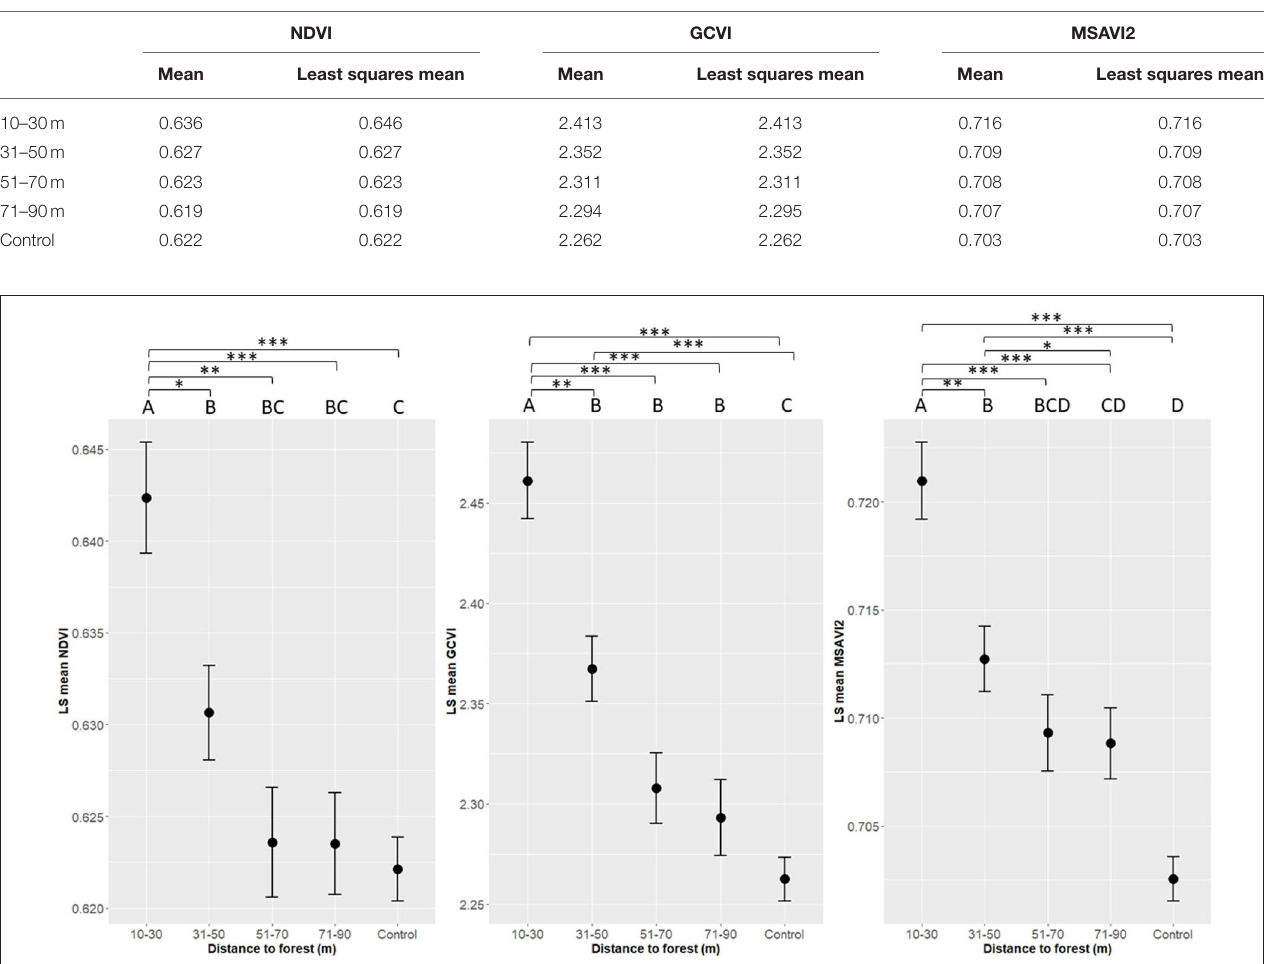
40 for all distance classes, n =